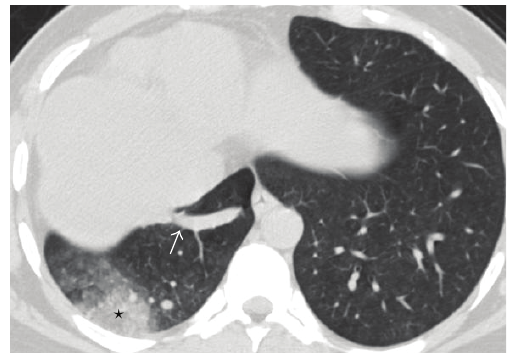
Figure 3: CT axial image depicts sequestration as patchy consolida- tion at right posterobasal region (asterix), meandering right inferior pulmonary vein (arrow).